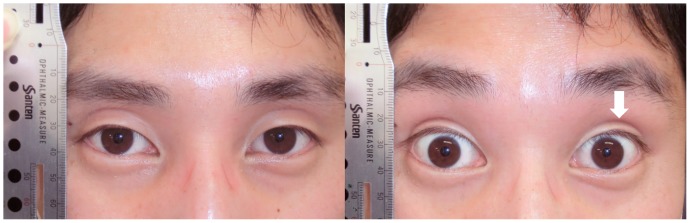
A younger subject judged to have a DUES-like appearance.A healthy 28-year-old male with a DUES-like appearance of the left eye. An UES was judged to be present when he had natural open eyes. All other signs were judged to be negative.